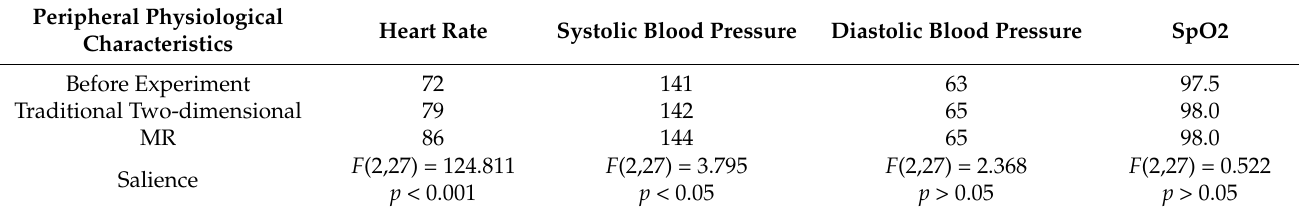
Table 4. Peripheral physiological characteristic data of traditional two-dimensional display interactive system and MR display interactive system.